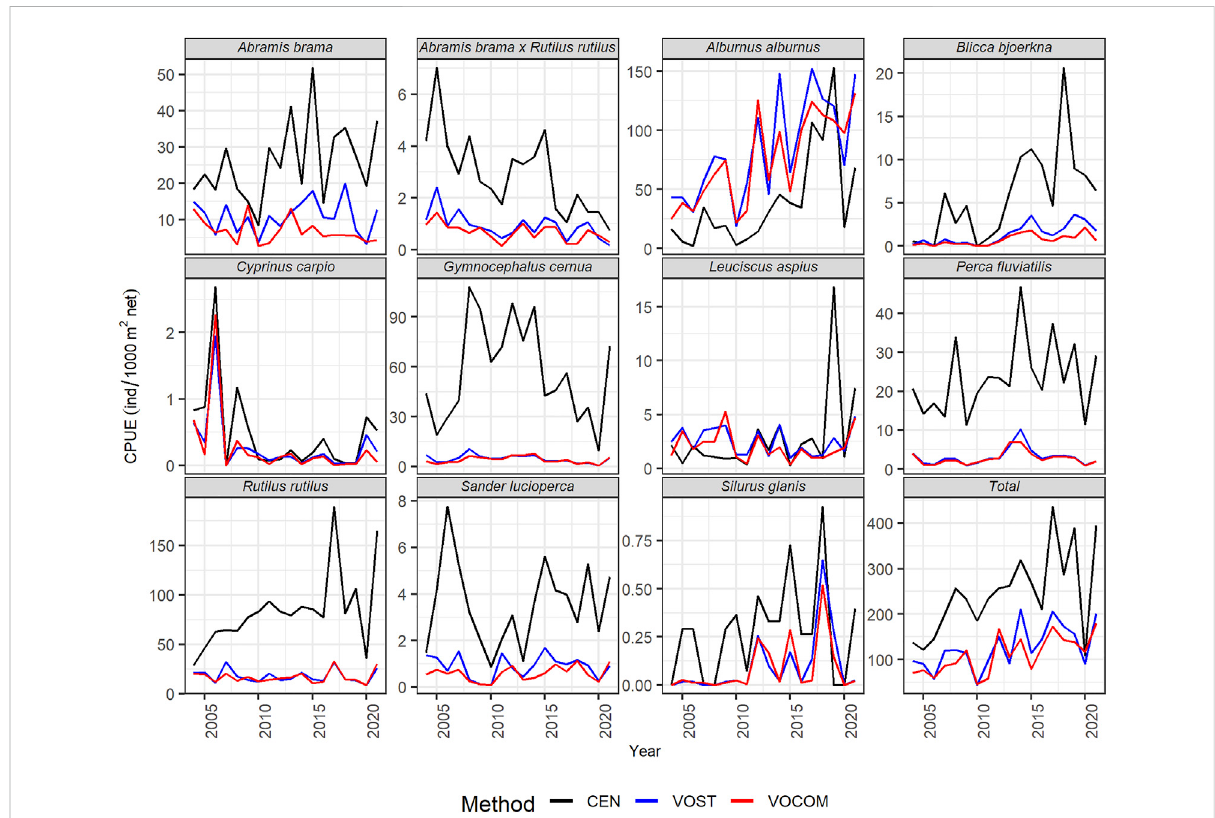
FIGURE 2 Estimated time-series whole-reservoir CPUE of the dominant fi sh species and the whole fi sh community (total) in the Ř ímov Reservoir derived from CEN, VOST, and VOCOM